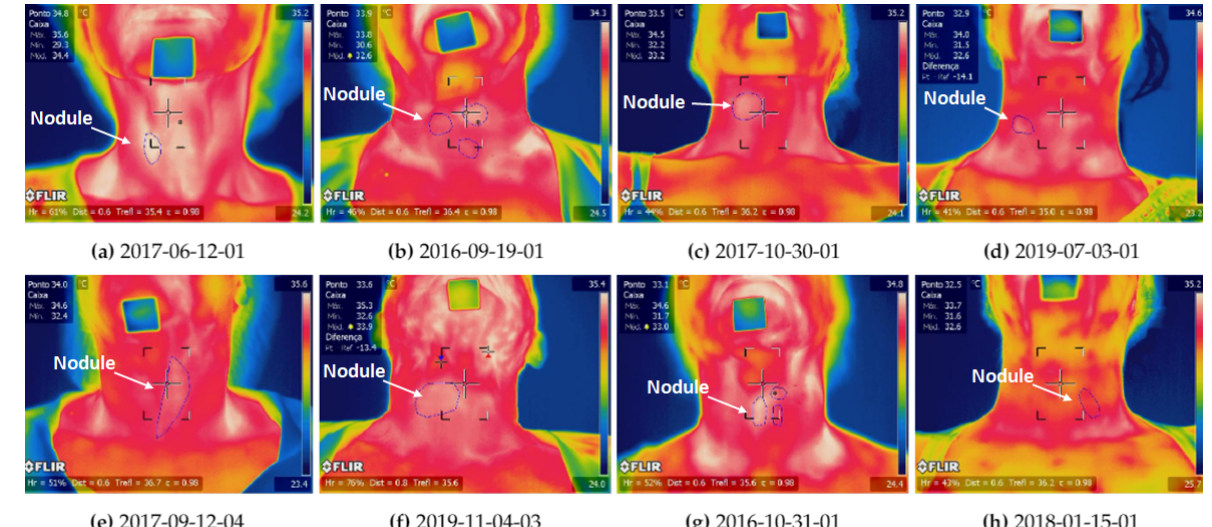
Figure 6. The last thermogram of eight patients, where it is possible to see the position and size of the nodules marked with a fine line by endocrinologists. Details of each person are in Table 3. Table 3. Volunteers identification, diameters of their nodules, nodular ultrasound characteristics (micro-calcification, complete halo, regular contours, heterogeneity, and the Chammas vascularization pattern), cytopathological result using the Bethesda classification, volunteer body characteristics (temperature, mass, height, BMI), and the diagnostic of the